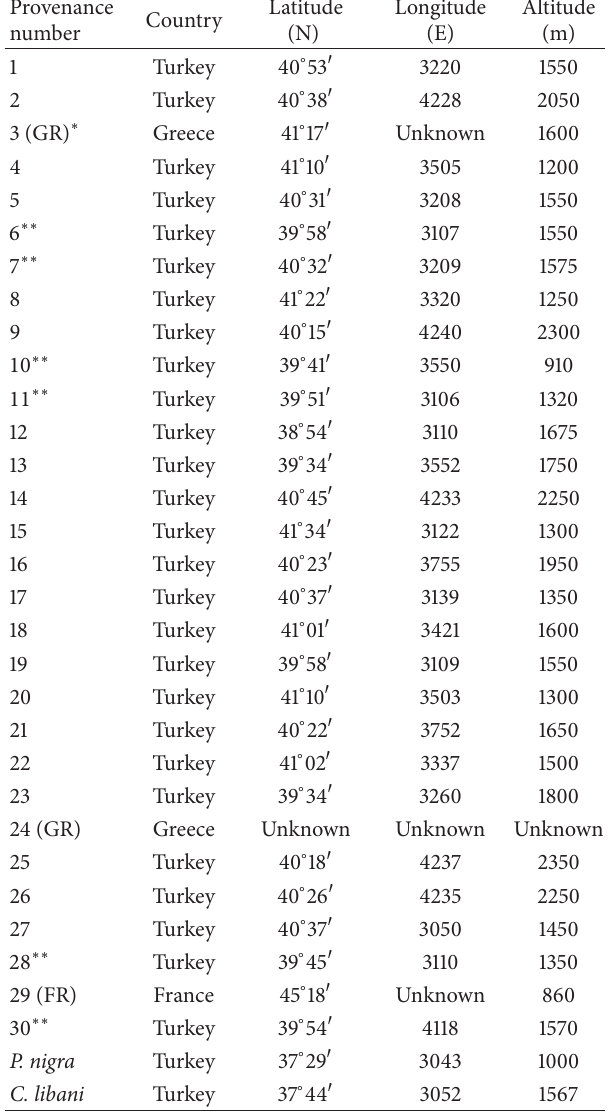
∗ GR: Greece; FR: France. ∗∗ Seed